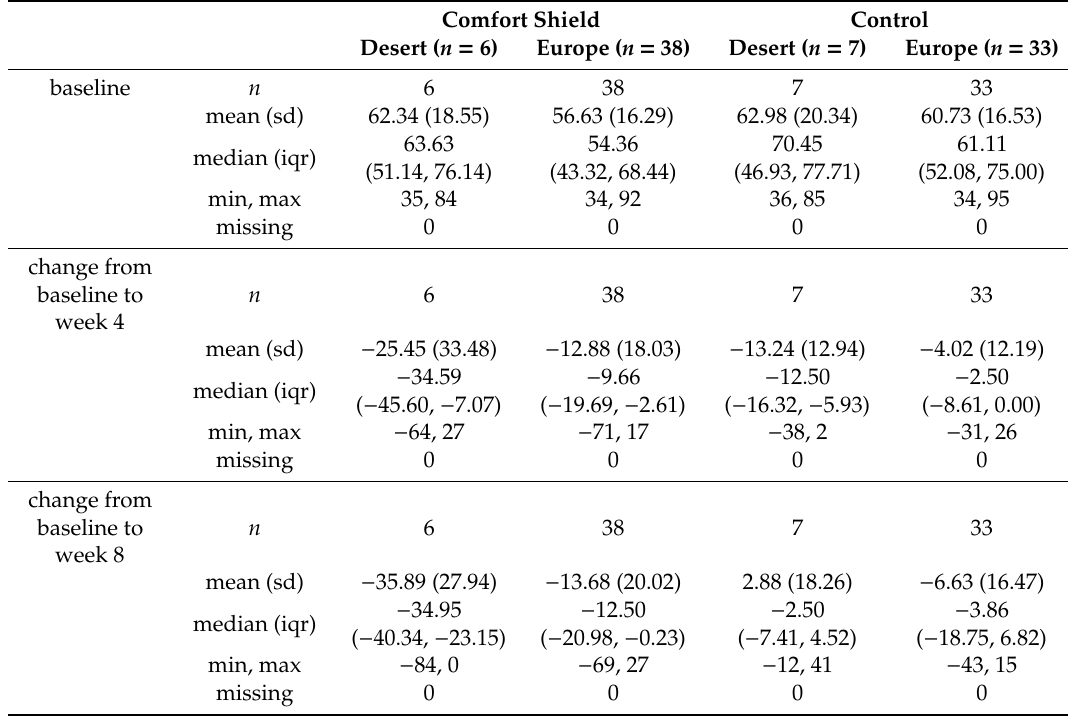
Table A8. OSDI: Value at baseline and change from baseline to each post-baseline visit—PPS ( n = 84)—descriptive analysis by